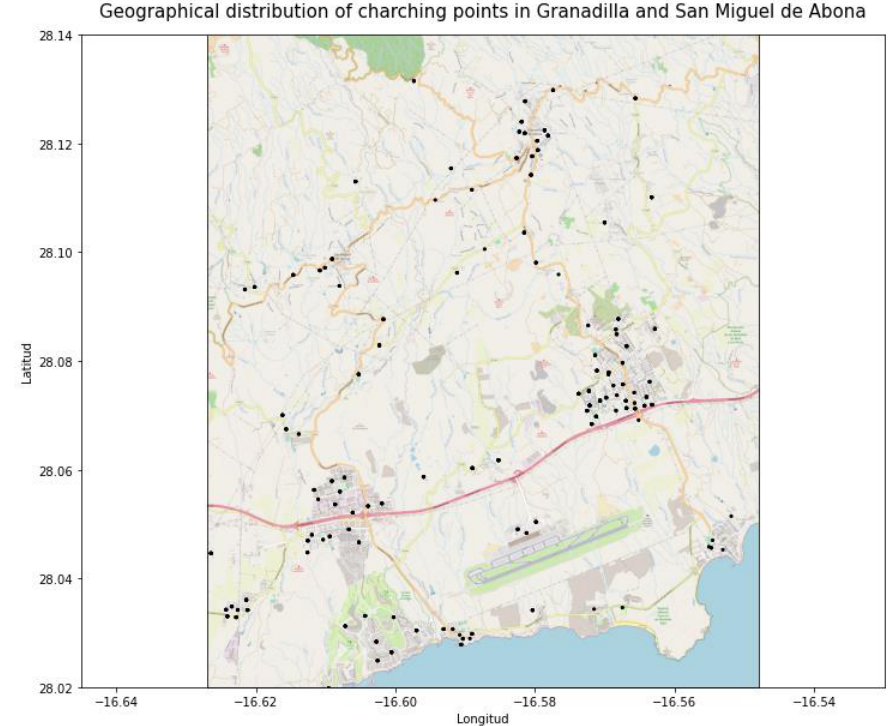
Figure 21. Distribution of charging points in Granadilla and San Miguel de Abona with each black dot representing a charging point.